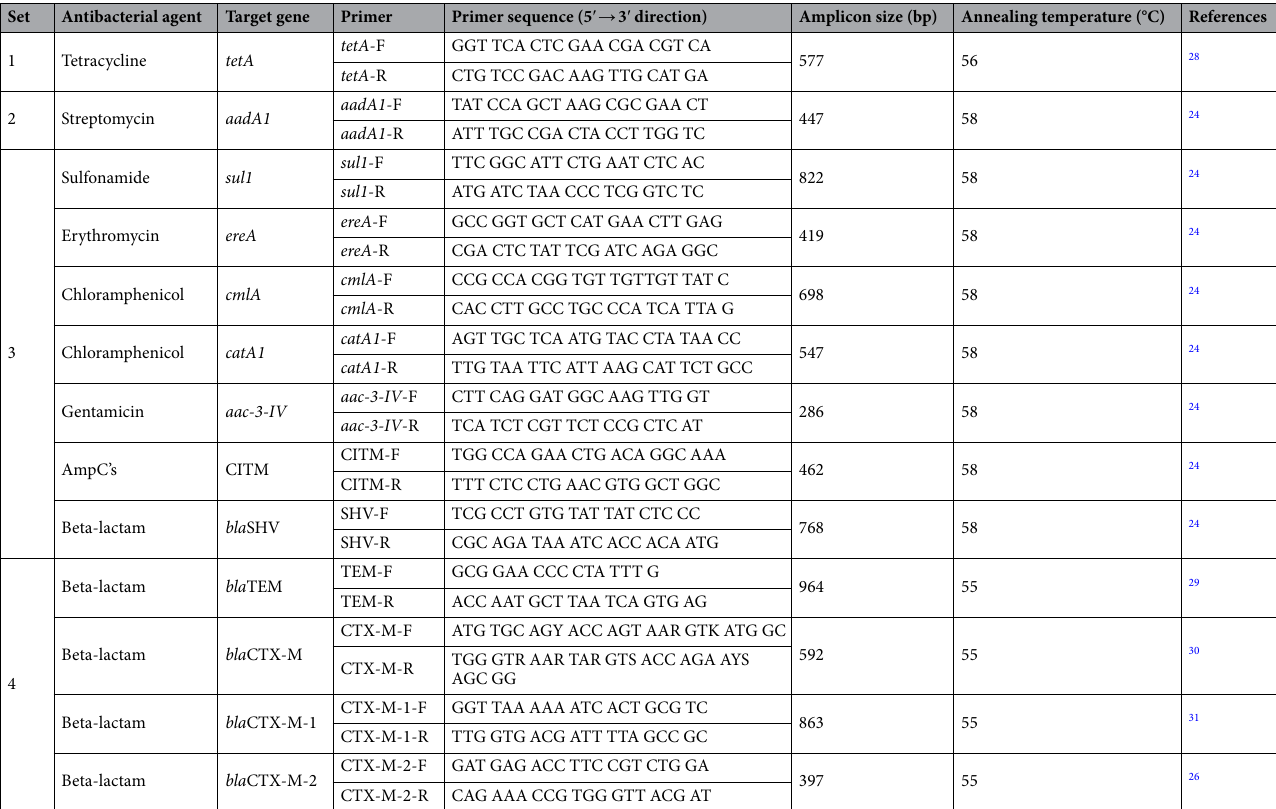
Table 1. List of primers used in the current study for uniplex (sets 1 and 2) and multiplex (sets 3 and 4) PCR assay formats for the amplification of beta-lactam and non-beta-lactam ARGs in the investigated E. coli isolates. F forward primer, R reverse